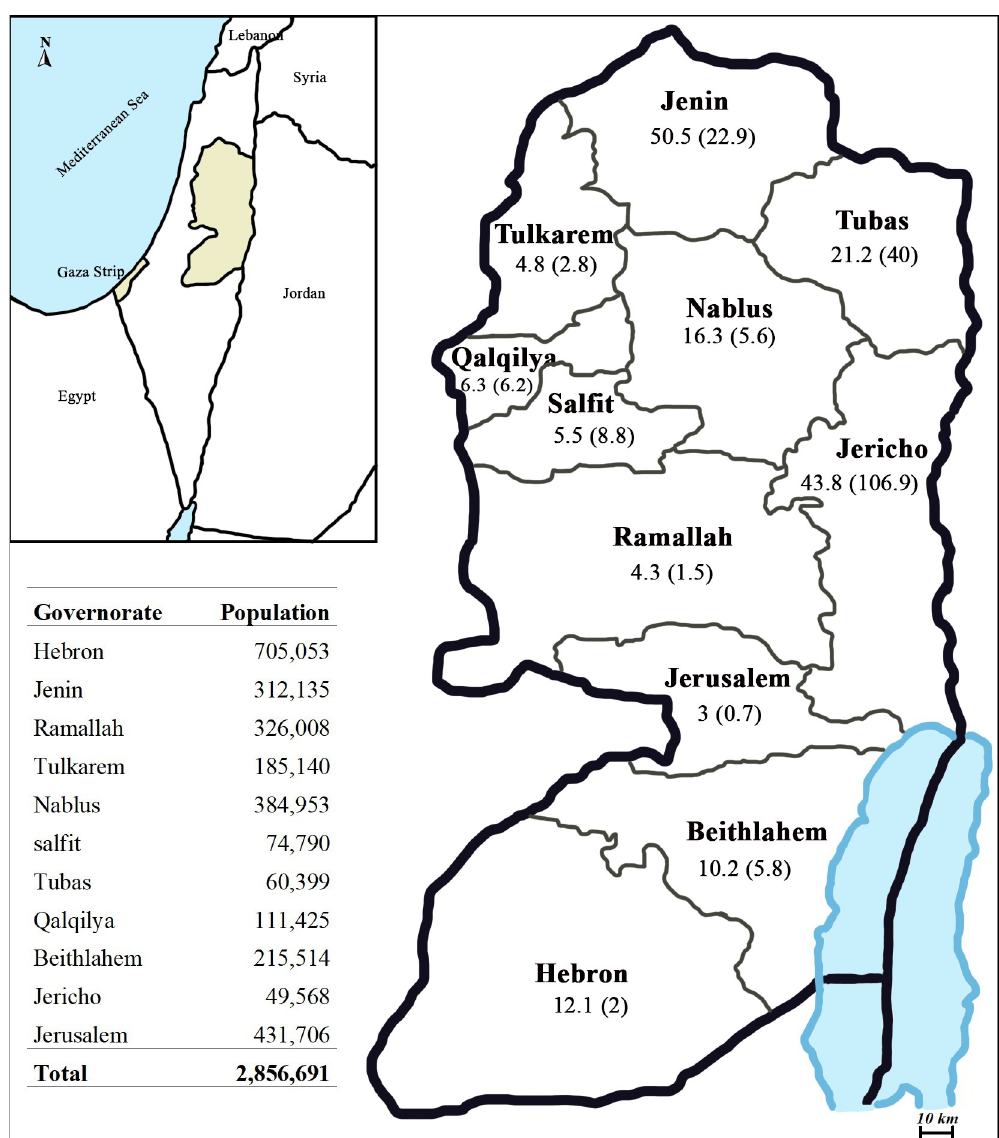
Fig 1. Distribution map of human cutaneous leishmaniasis in Palestine 1990–2020. The location of Gaza Strip and West Bank, Palestine (top left). Geographical distribution of human cutaneous leishmaniasis between 1990 and 2020 in each endemic governorate in the West Bank. No cases were reported from Gaza Strip. CL cases are represented by the average number of patients/year, and in parenthesis the average annual incidence rate/100.000 population calculated for each governorate from 1990 until 2020. Table 1 shows the mid-year population as estimated by the Palestinian Central Bureau of Statistics PCBS in 2017. Maps were created, adapted and edited from the freely available sources (http://eol.jsc.nasa.gov/ sseop/clickmap/) by Adobe Photoshop CC